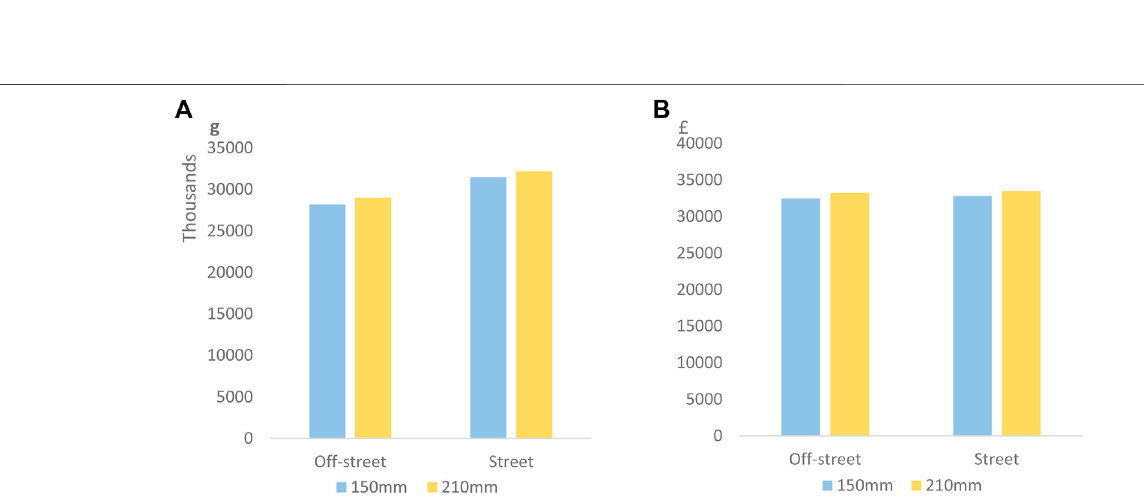
Frontiers in Built Environment |